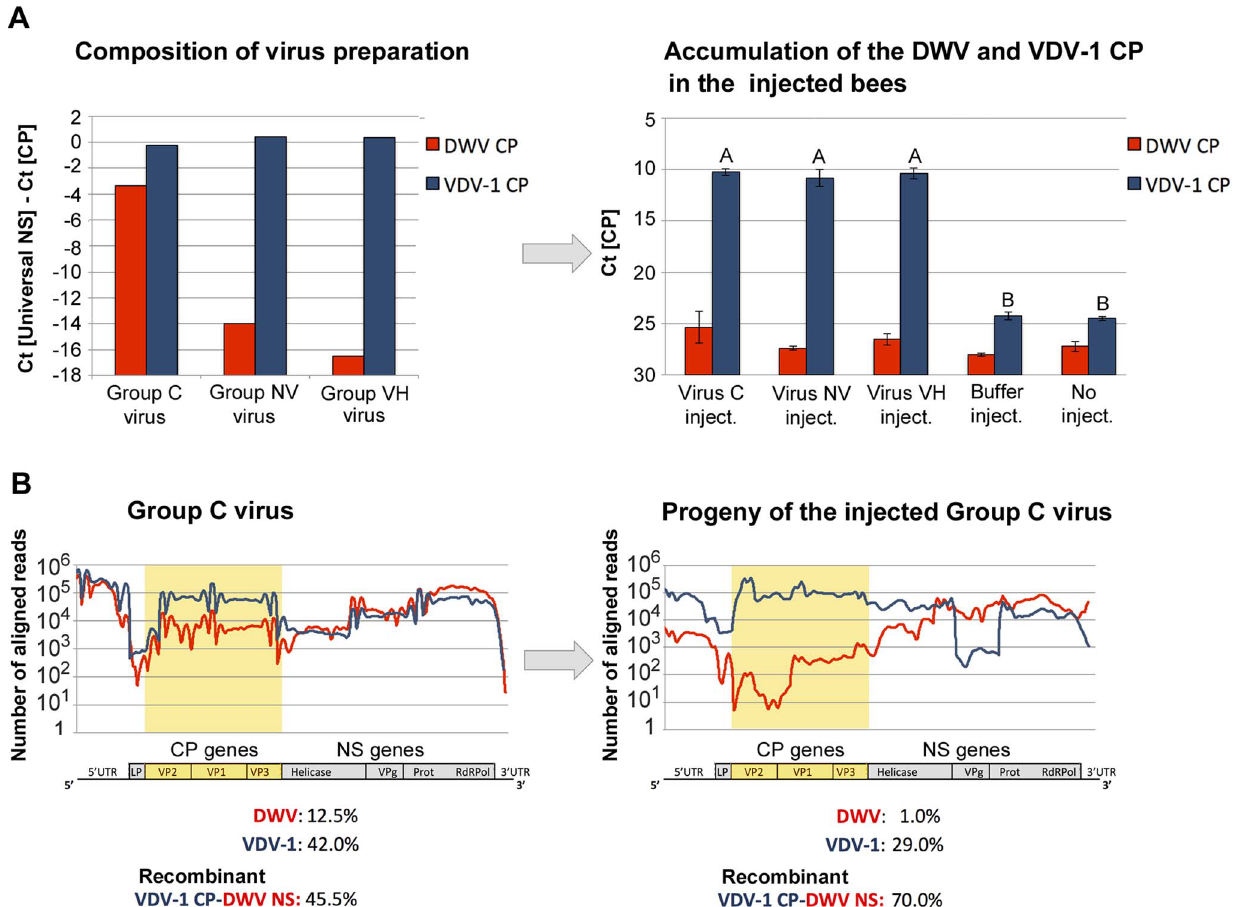
Figure 6. Changes in the strain composition of DWV complexes in honeybee pupae following direct injection of virus. Levels of the DWV- and VDV-1 CP-coding RNA determined by qRT-PCR (left panel) in the virus preparations used for injection, and (right panel) in pupae following incubation for 3 days. (A) Left panel: D Ct values for the DWV-type and VDV-1-type CP were obtained by subtracting Ct values for the corresponding CP from Ct for the total DWV-like viruses quantified using ‘‘Universal’’ primers to the NS gene. Right panel: Ct values for the DWV-type and VDV-1- type CP. Six pupae were used for each virus-injected group, three pupae were used for each of the buffer-injected and non-injected control groups. Bars show mean value with standard error. Letters above the bars represent statistically significant groupings according to pairwise t -test comparisons for VDV-1 CP ( p -value , 0.01). (B) High-throughput sequencing of the virus preparations from the honeybees of group C (left), and the virus accumulated in the pupae injected with 20 ng of the virus preparation (right), 3 days post injection. The graphs show depth of coverage at genomic loci in DWV (red) and VDV-1 (blue) determined by high-throughput sequencing of viral RNA aligning to the DWV and VDV-1 sequences (GenBank Accession numbers GU109335 and AY251269 respectively). Only reads unambiguously aligning to DWV or VDV-1 sequences were used, with up to 3 mismatches tolerated in the 18 nt. seed region. The percentages of DWV, VDV-1 and the DWV-VDV-1 recombinants predicted by MosaicSolver [40] are shown below. The pileup graphs for DWV and VDV-1 are shown, respectively, in red and dark blue. The CP-coding region of the virus C preparation and the virus C-injected pupae, which shows a decrease of DWV coverage compared to the injected virus, is highlighted in yellow.